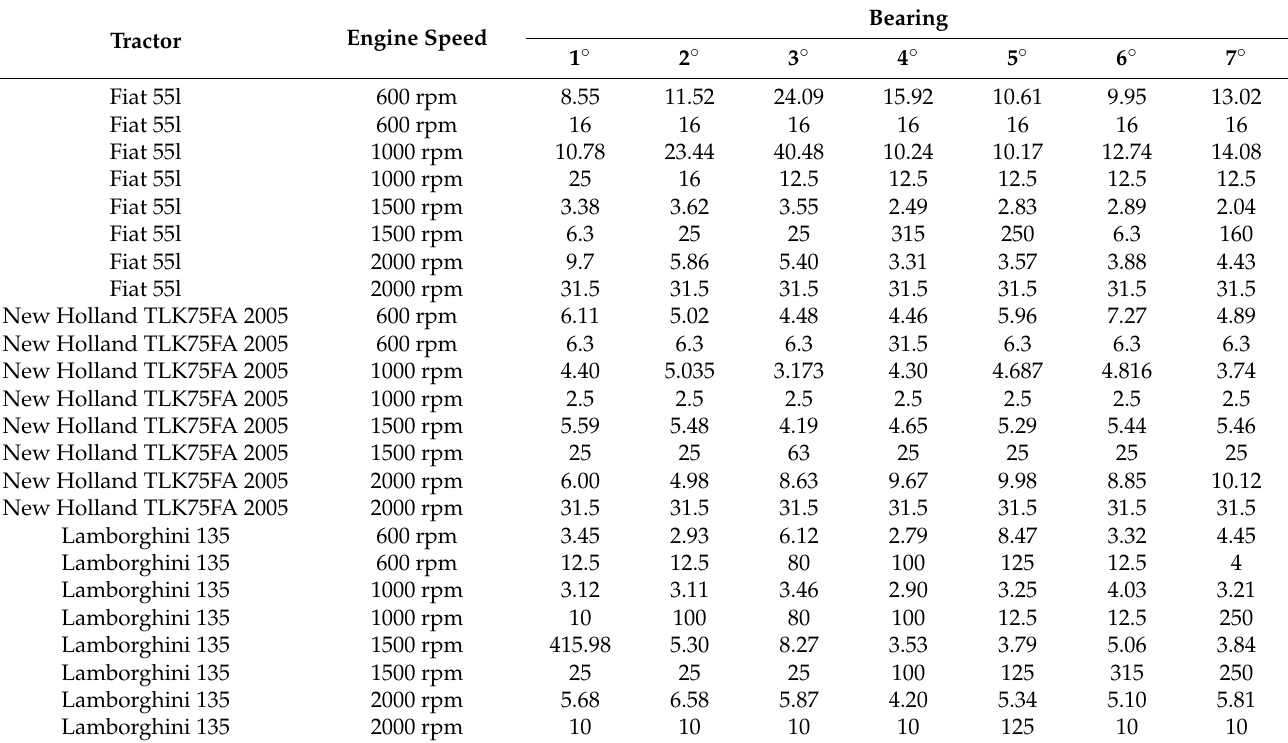
Table 2. Data obtained for the bearings of each vehicle at different engine